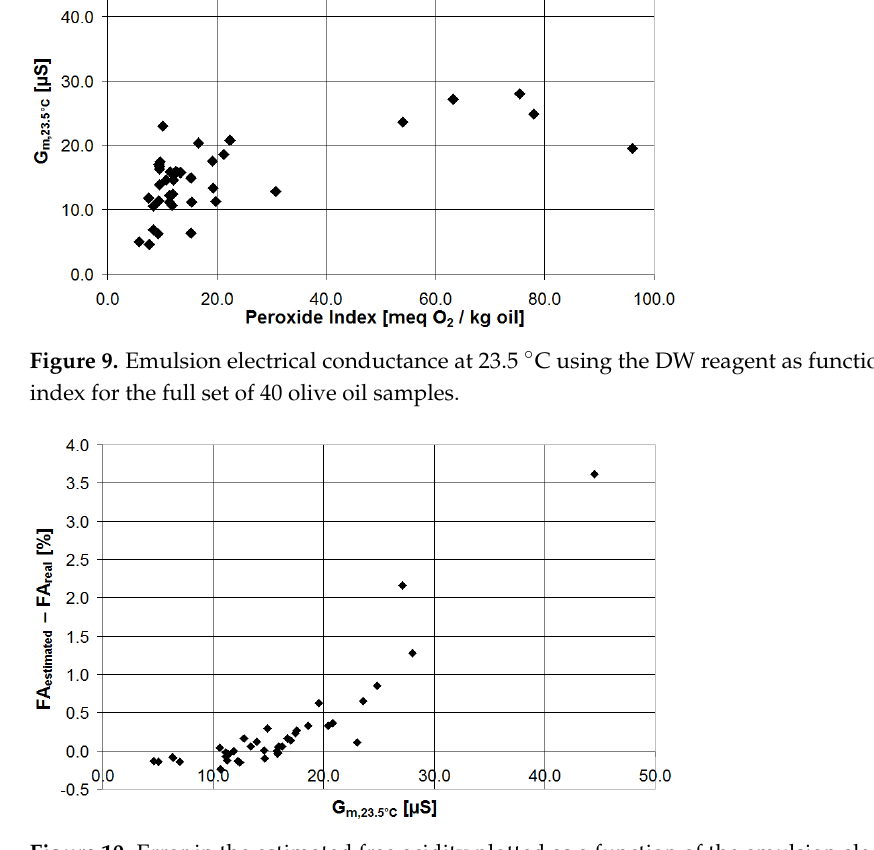
Figure 9. Emulsion electrical conductance at 23.5 °C using the DW reagent as function of peroxide index for the full set of 40 olive oil samples.